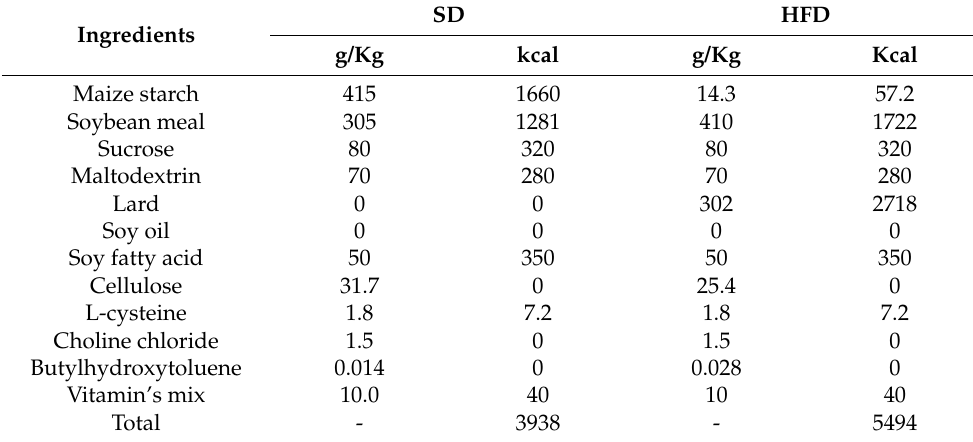
Table 1. Nutritional composition of standard diet (SD) and high-fat diet